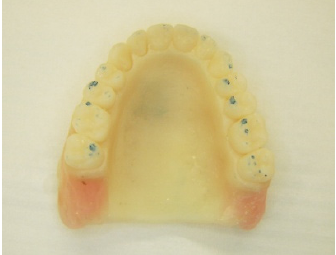
Figure 14. 3D-printed trial monolithic denture at the session of clinical evaluation. Unilateral occlusal contacts and wax corrections were detected.